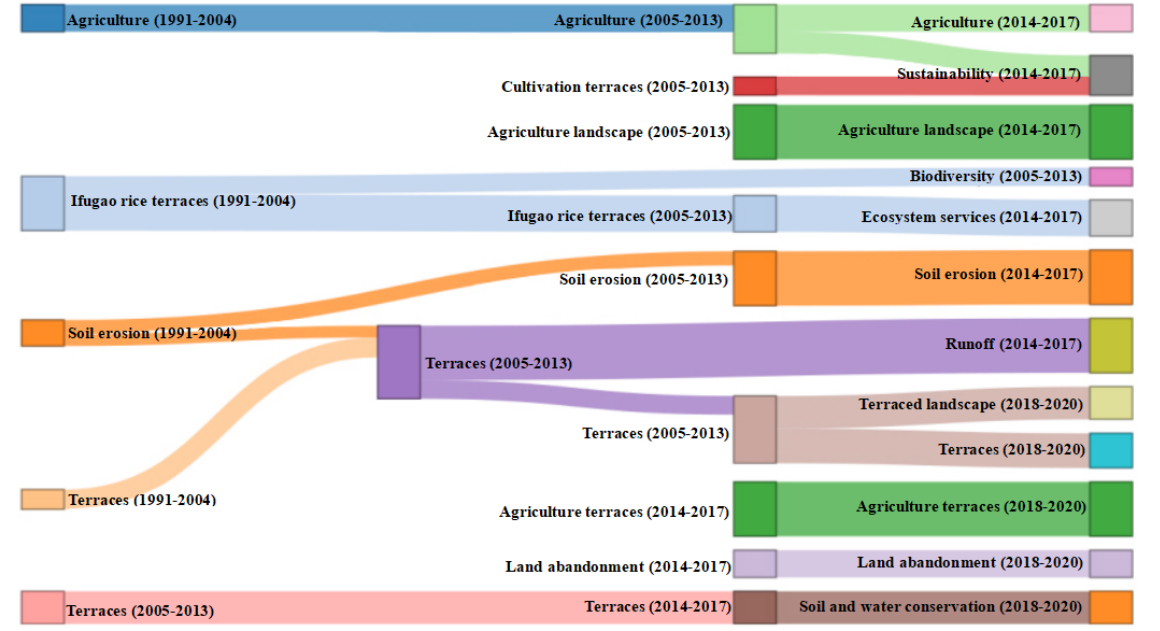
Figure 9. Thematic evolution of agricultural-terrace research (1991 – 2020).